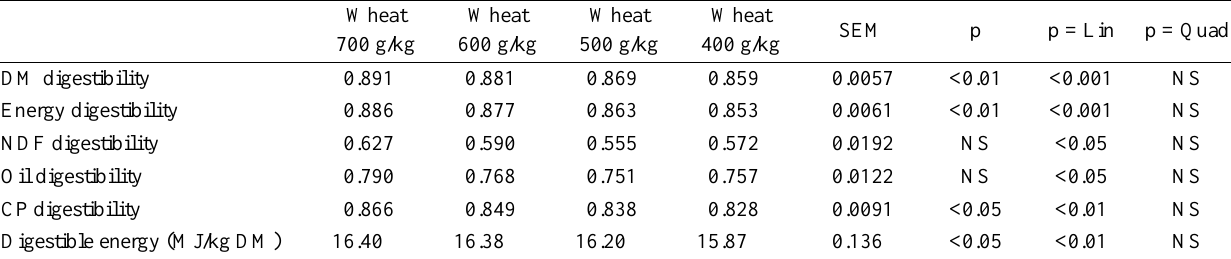
Table 5. The effect of dietary inclusion level of wheat on nutrient digestibility and nitrogen balance in finishing pigs housed